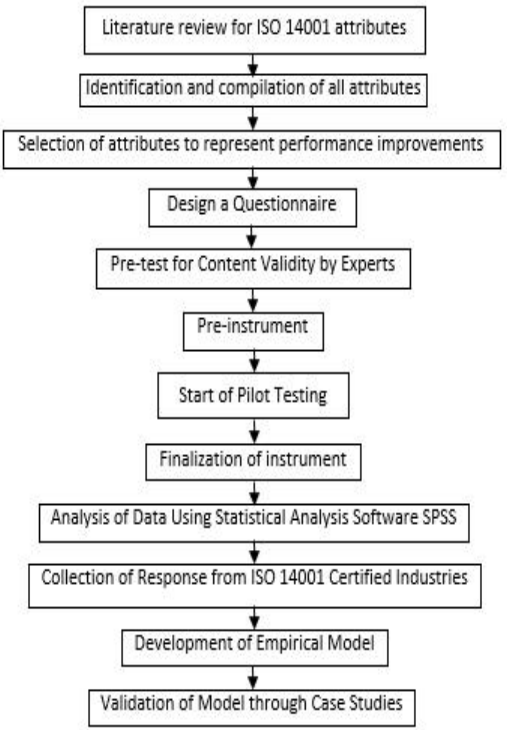
Fig.1: Flow chart for research